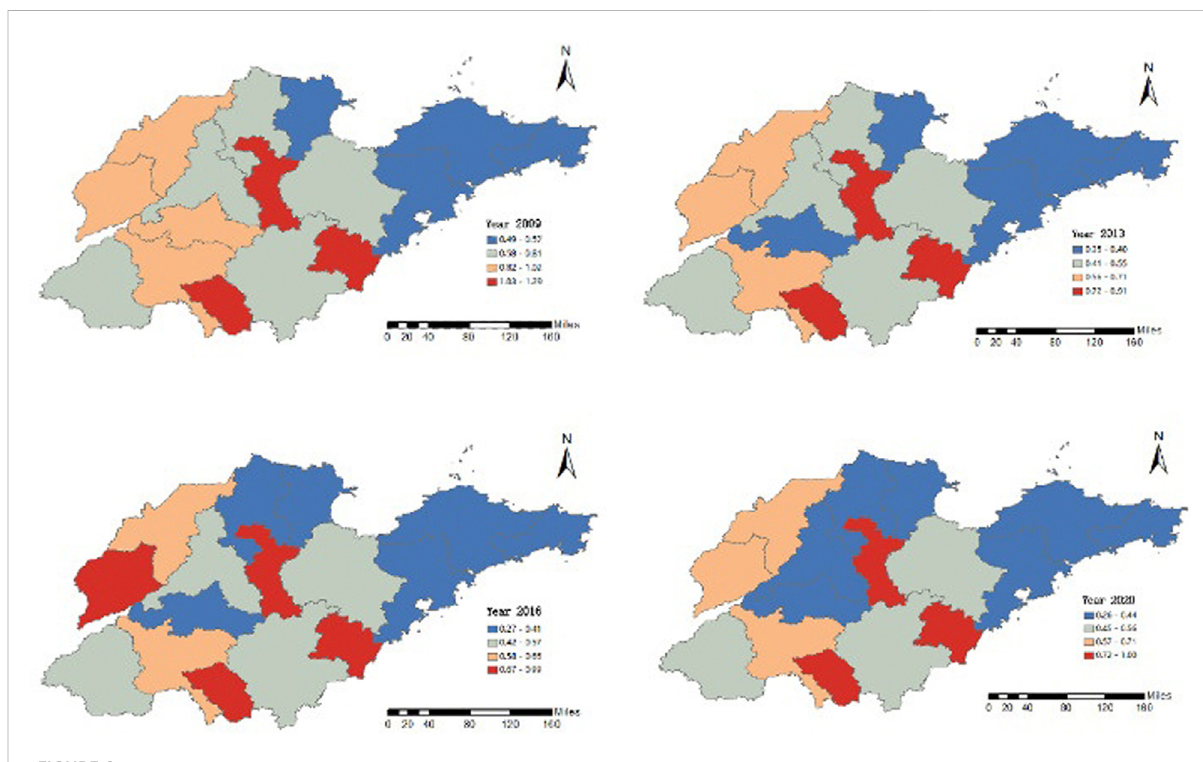
FIGURE 2 Carbon emission intensity of 16 cities in 2009, 2013, 2016 and